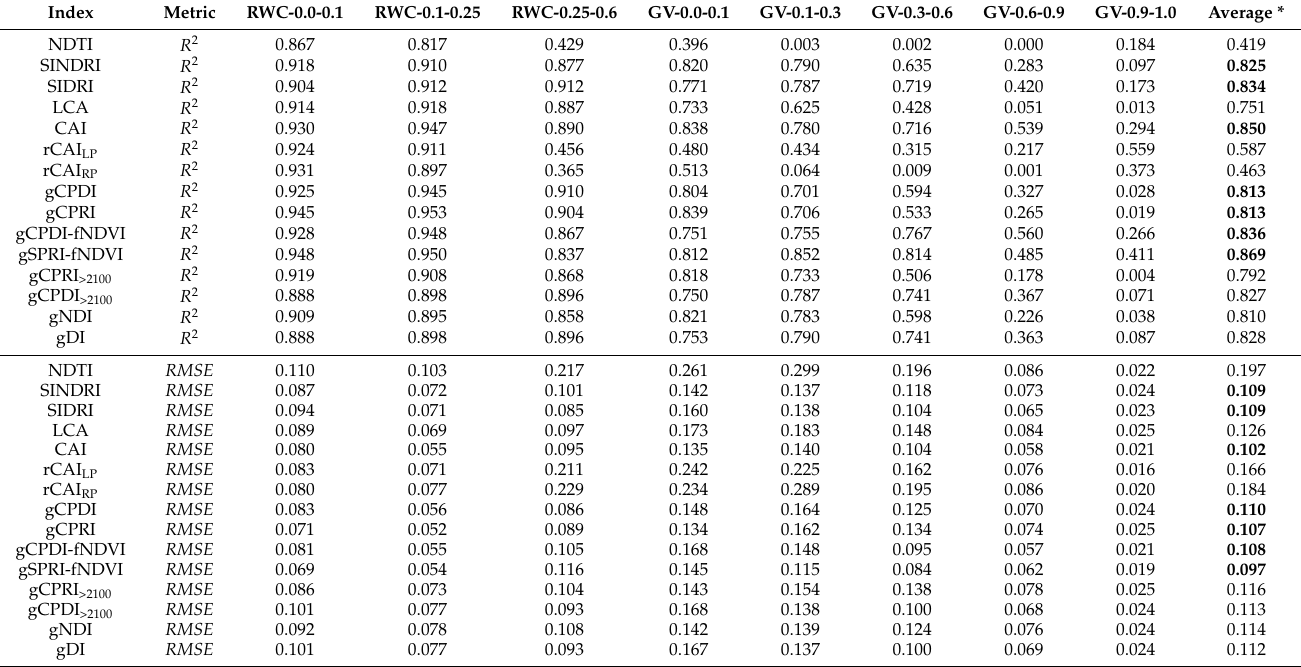
Table 5. Comparison of f R estimation results for each index by RWC and f GV (GV) classes. The last column is an average computation of index performance across all RWC classes and the GV classes from 0.0 to 0.6 (* denotes higher f GV classes were excluded from computation). The best performing RMSE (with associated R 2 ) are indicated by bold text (two 2-band indices and five 3-band indices). The central wavelengths and ranges for bands 1, 2, and 3 in the best performing three-band indices are used to establish final band